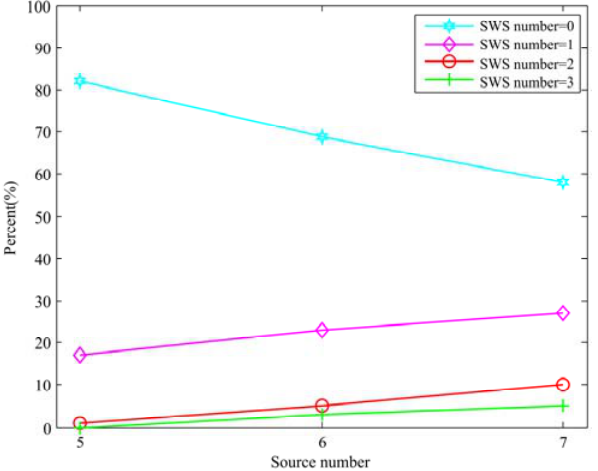
Figure 8. Statistical analysis for the existence of SWS in 30 ◦ angle between sources scenario exploit SDSCR algorithm.